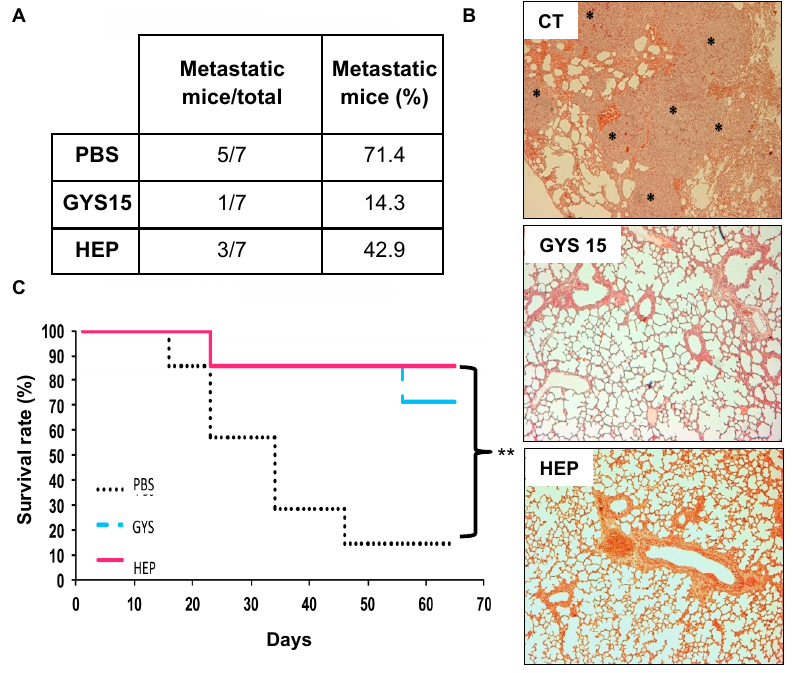
Figure 7. Effect of OS-EPS 15 kDa derivative on the lung metastatic incidence: ( A ) metastatic incidence in treated animals (OS-EPS derivative or heparin; s.c. 6 mg/kg daily) vs. control (PBS); ( B ) histological analyses of the lung tissue of treated animals or not (* metastatic foci), original magnification: 400×; and ( C ) survival rate (%) of treated animals (OS-EPS derivative or heparin) compared to the control group (PBS), Kaplan–Meier survival curves. n = 7 mice/group; ** p < 0.01.